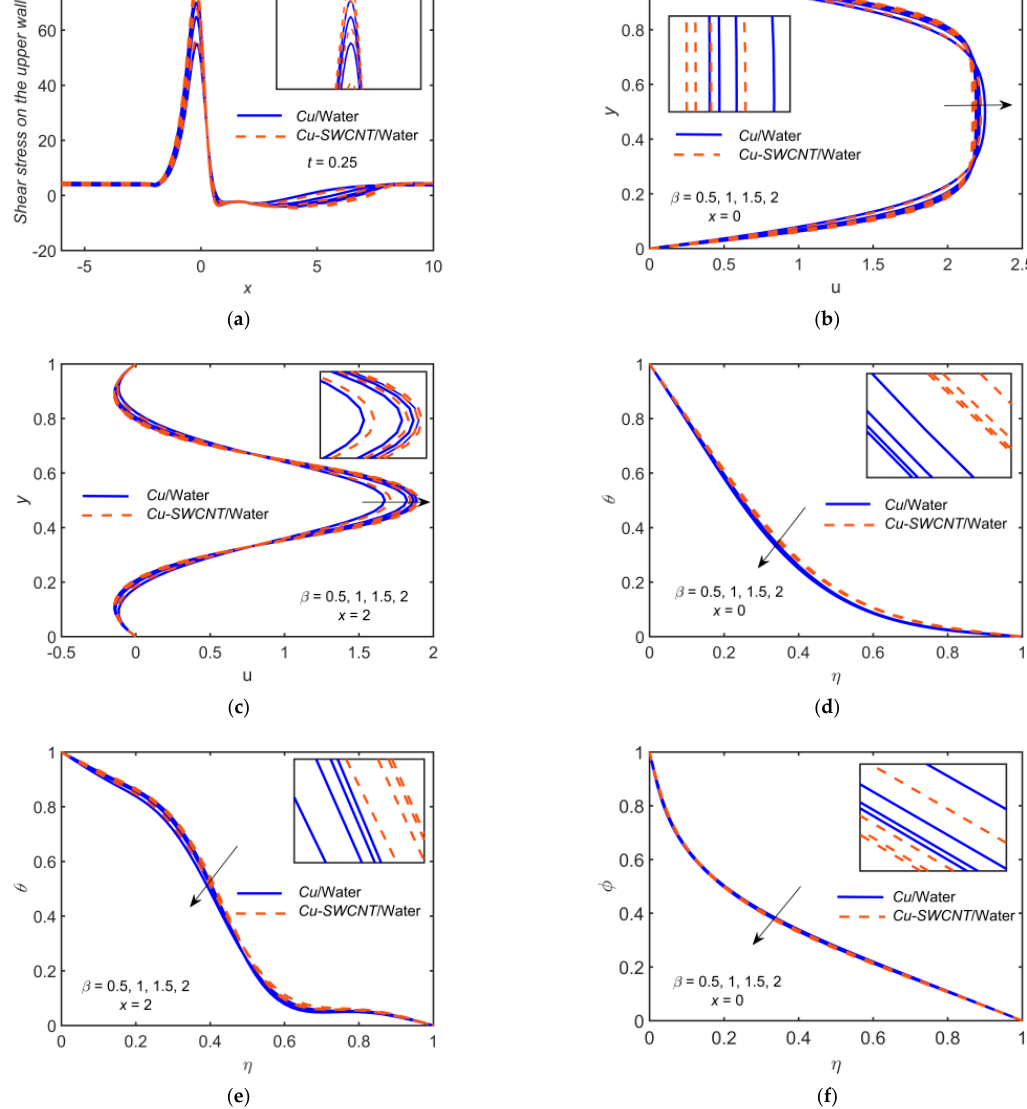
Figure 5. ( a ) The WSS distribution, ( b ) 𝑢 profile at 𝑥 = 0 , ( c ) 𝑢 profile at 𝑥 = 2 , ( d ) 𝜃 profile at 𝑥 = 0 , ( e ) 𝜃 profile at 𝑥 = 2 , and ( f ) 𝜑 profile at 𝑥 = 0 for distinct values of 𝛽 .